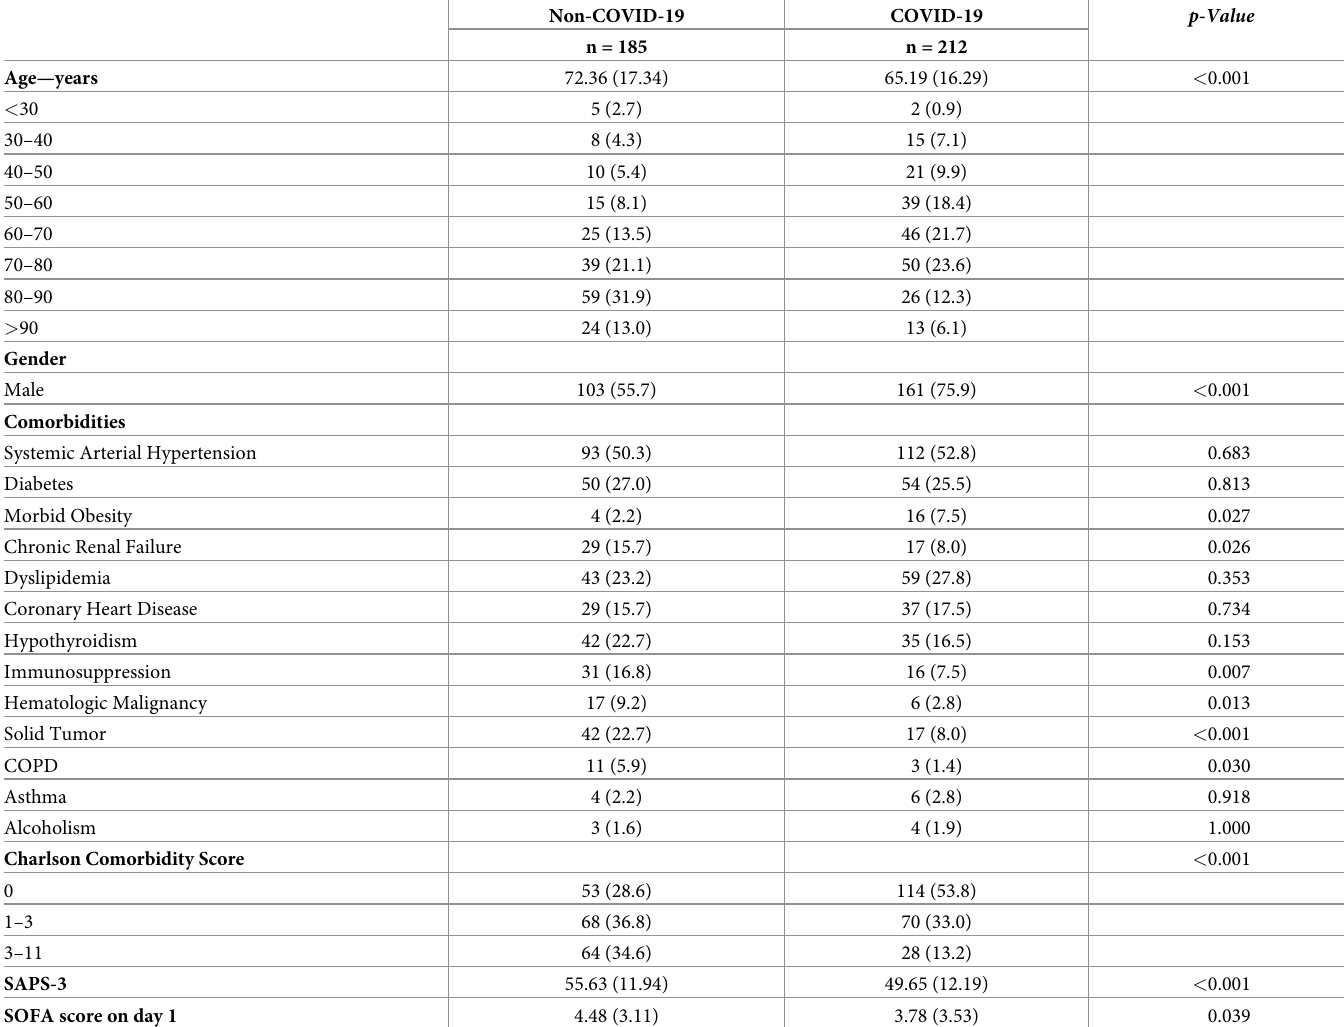
Table 1. Patients